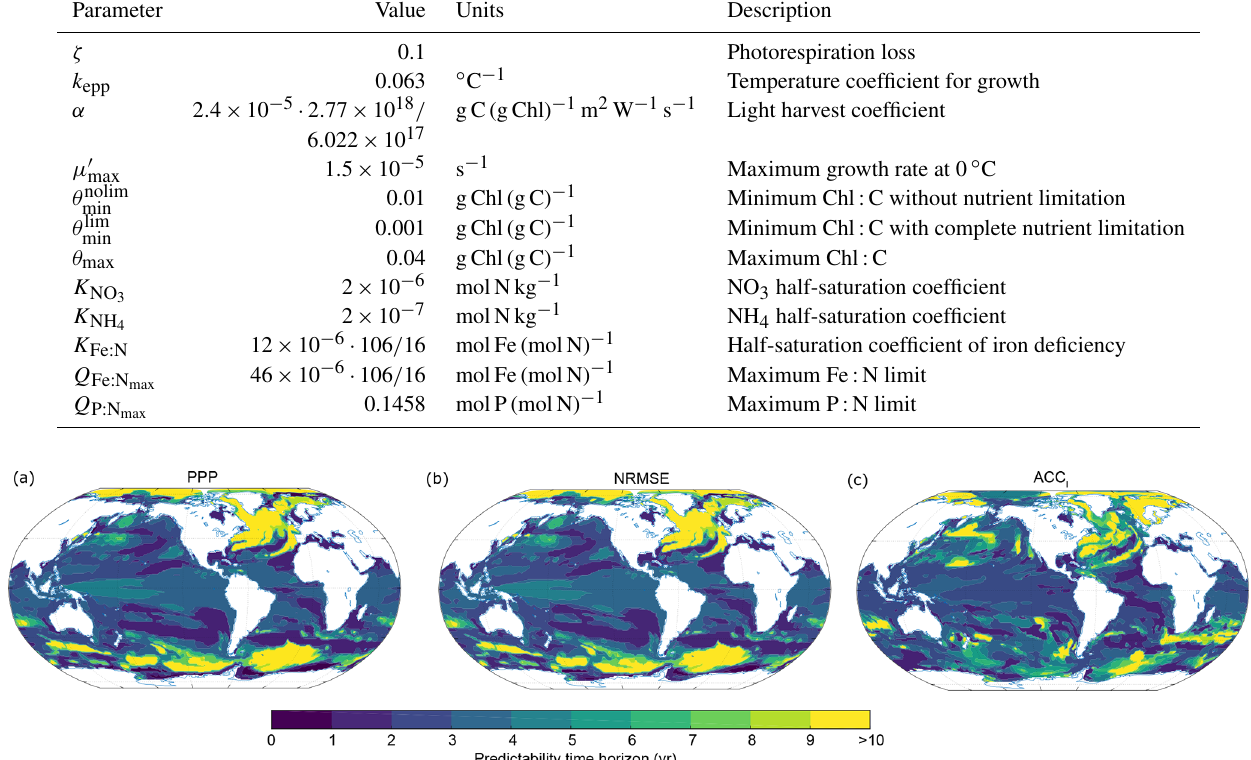
Table A1. TOPAZ2 parameters for small phytoplankton.